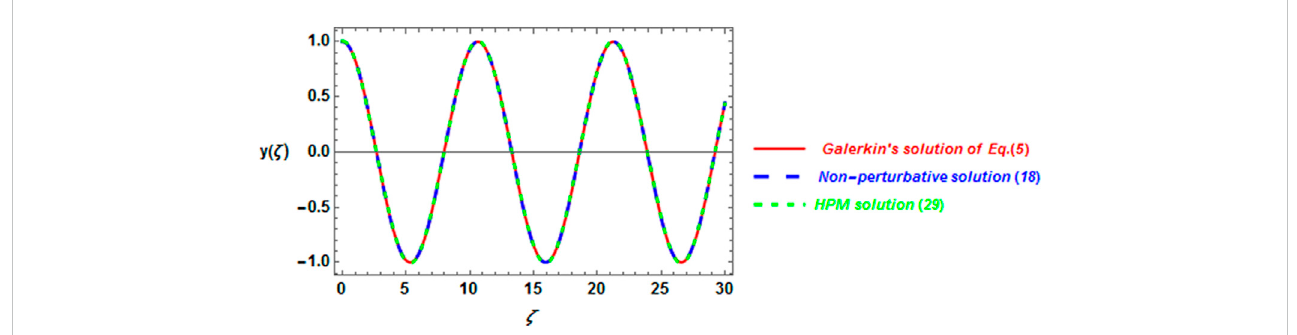
FIGURE 2 Comparison between the analytical periodic solutions by the non-perturbative and homotopy perturbation approaches (18) and (29), respectively, with Galerkin ’ s solution (Eq. 32).